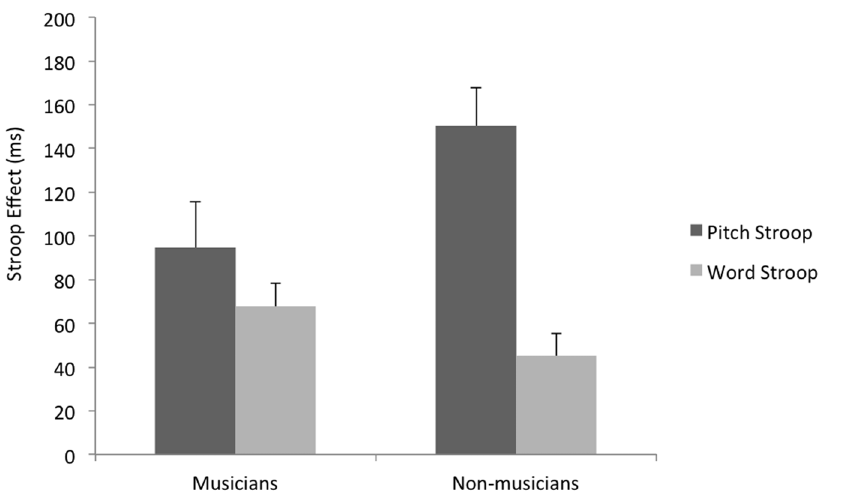
Figure 1. Mean Stroop effects for musicians and non-musicians on the pitch-conflict and word-conflict conditions. Musicians showed similar Stroop effects for the pitch and word conflict conditions, but non-musicians showed a significantly larger Stroop effect for the pitch condition compared to the word condition. Error bars are standard errors.